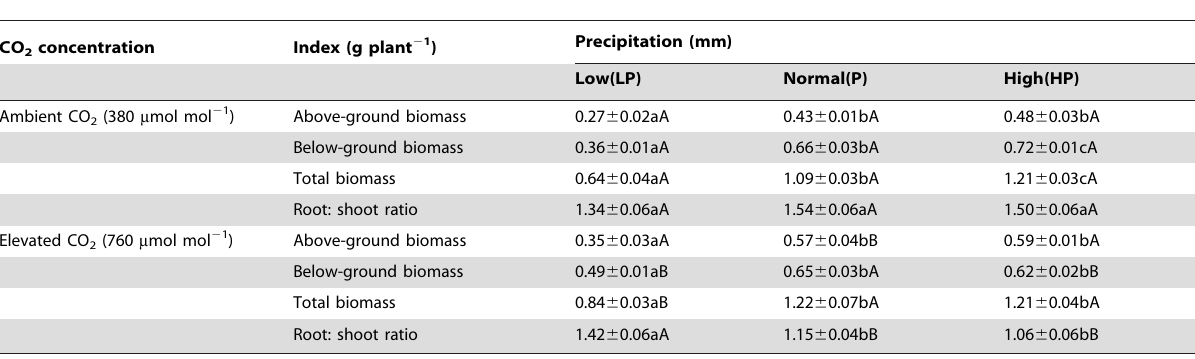
Note: Different lower-case letters indicate a significant difference among precipitation levels and different capital letters indicate a significant difference between the two CO 2 levels ( P , 0.05). Low/High precipitation were defined as normal precipitation + / 2 40%.